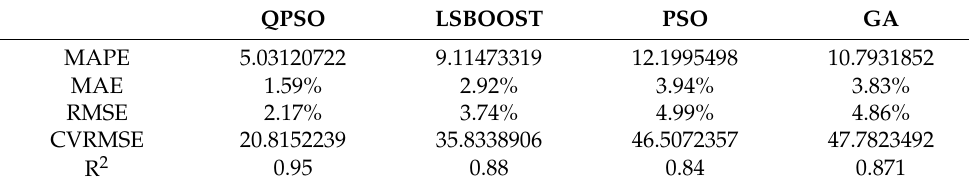
MAPE, mean absolute percentage error; MAE, mean absolute error; CVRMSE, coefficient of variation of root mean square error; R 2 , coefficient of